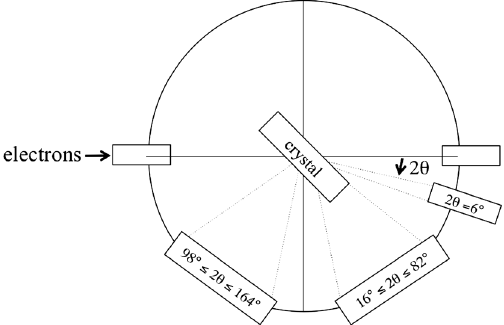
FIG. 7. The dependence of χ on x-ray energy for diamond and Si with the Miller index